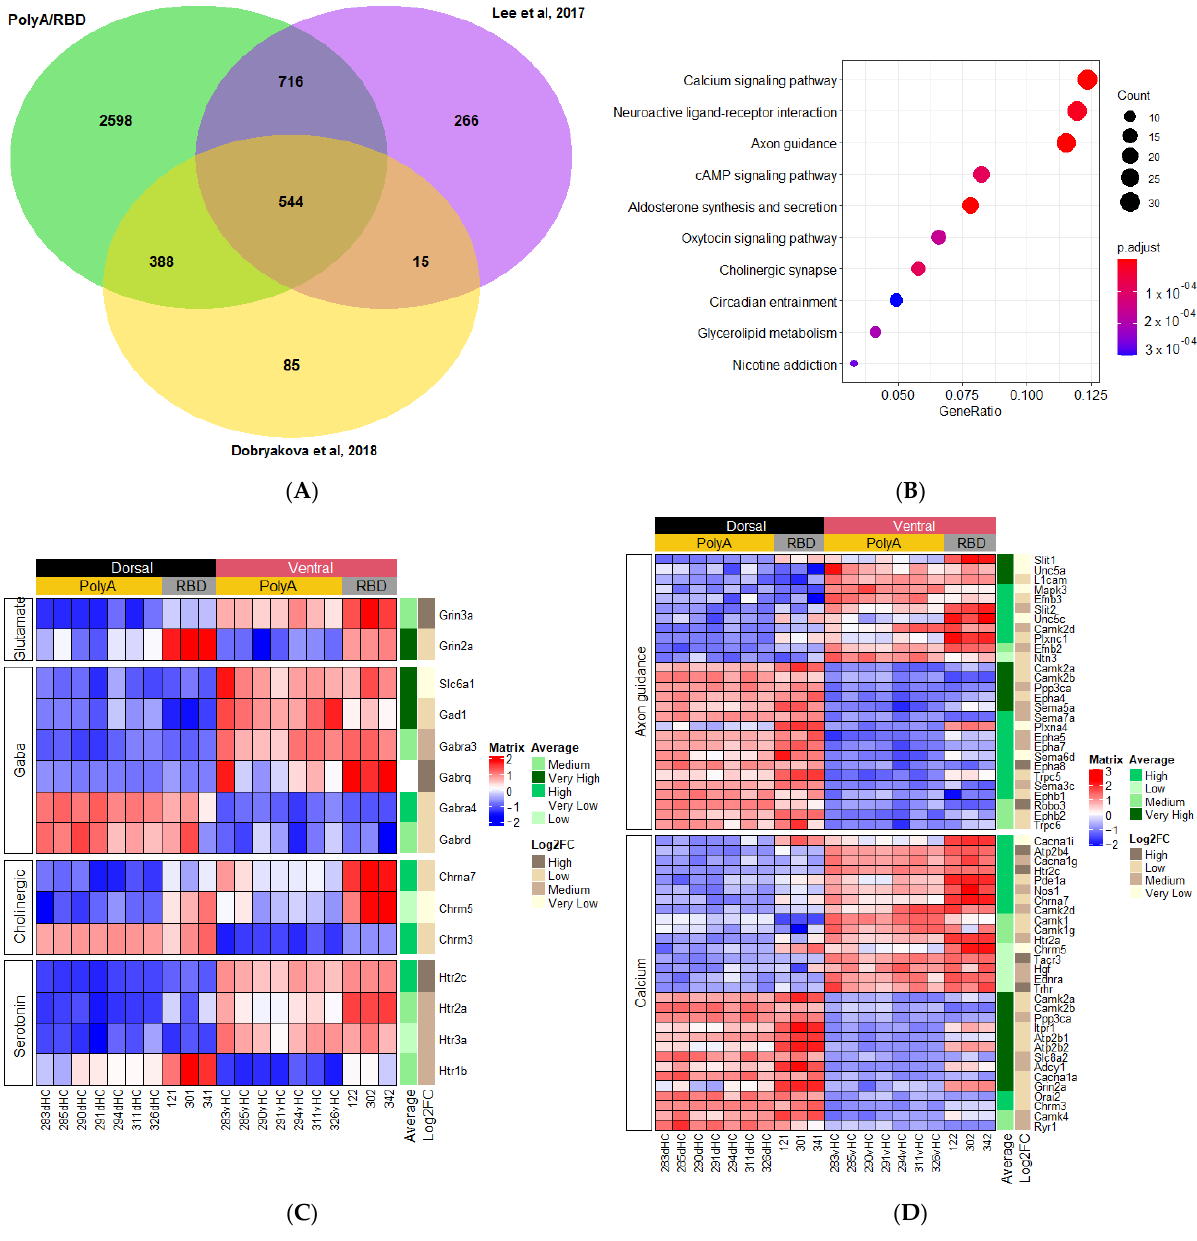
Figure 6. ( A ) Intersection between genes differentially expressed (VH vs. DH) in PolyA/RBD conserved gene set (4275) (green), our previously published data [13] (yellow), and hippocampal development dataset from [14] (purple). ( B ) KEGG plot for 544 genes that fall into intersection. ( C , D ) Heatmaps showing neurotransmitter and calcium/axon guidance KEGG category genes from 544 ‘core’ set.